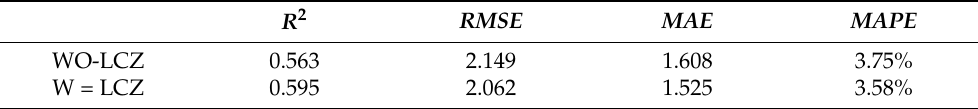
Table 6. Comparison of SUHI N prediction error parameters with and without the LCZ model. R